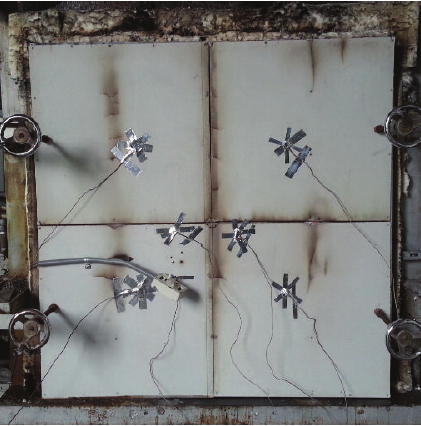
Figure 9: The result of the unexposed surface of the sample in Test 5.